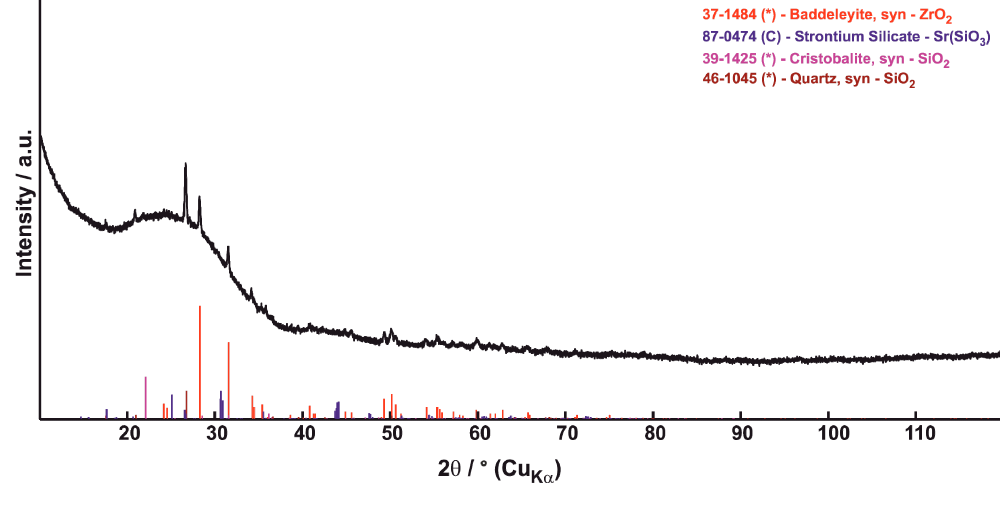
Figure 4. XRD patterns of the sample “1 h”. Table 2. XRD phases—semi-quantitative content (%).